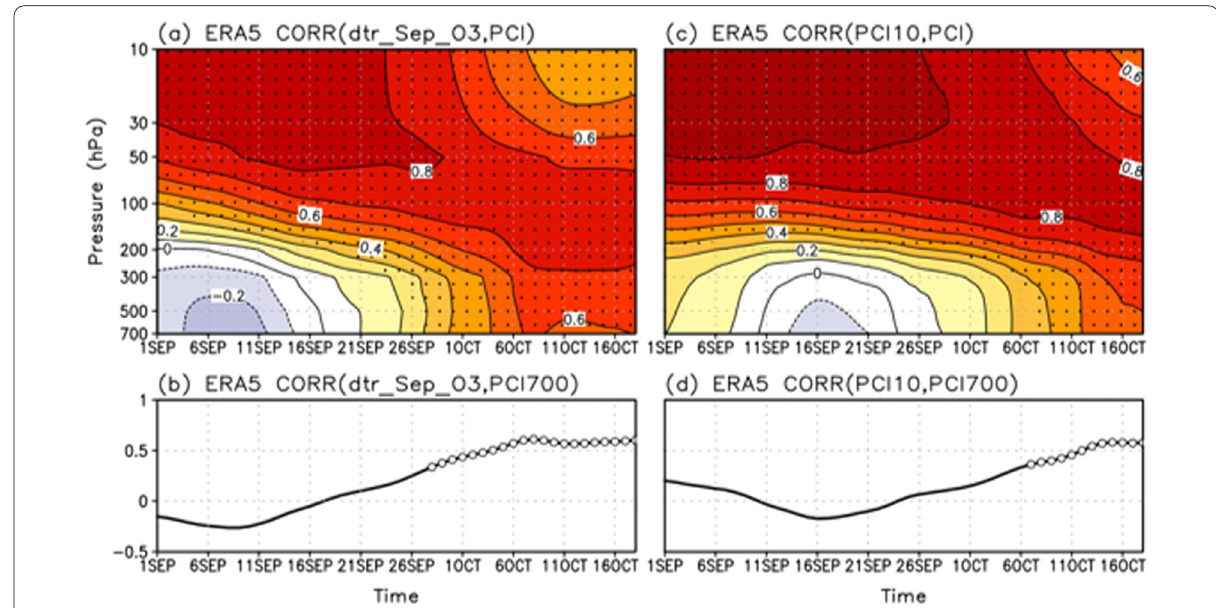
Fig. 1 a Time pressure distribution of lagged correlation coefficient between detrended September total column ozone anomaly and 14‑day running averaged PCI of ERA5 during the period of 1991–2020. Statistically significant values are hatched at the 95% confidence level. b Same as ( a ) but for the PCI at 700 hPa. Open circles denote the values which are statistically significant at the 95% confidence level. c , d Same as ( a , b ) but for PCI predicted by a linear regression model based on 10‑hPa PCI on 1st